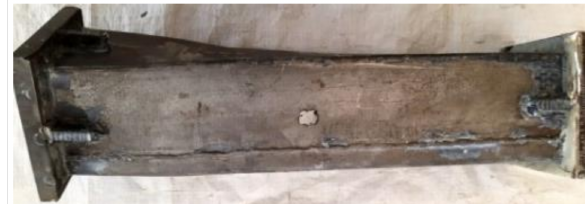
Figure 4. Failure model of steel tube.